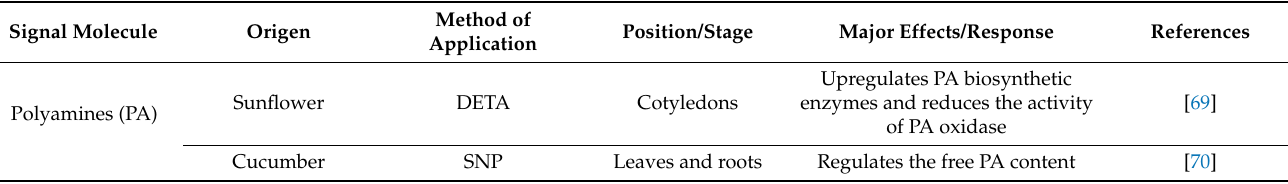
Table 1. Effects of NO and different signaling molecules under salt